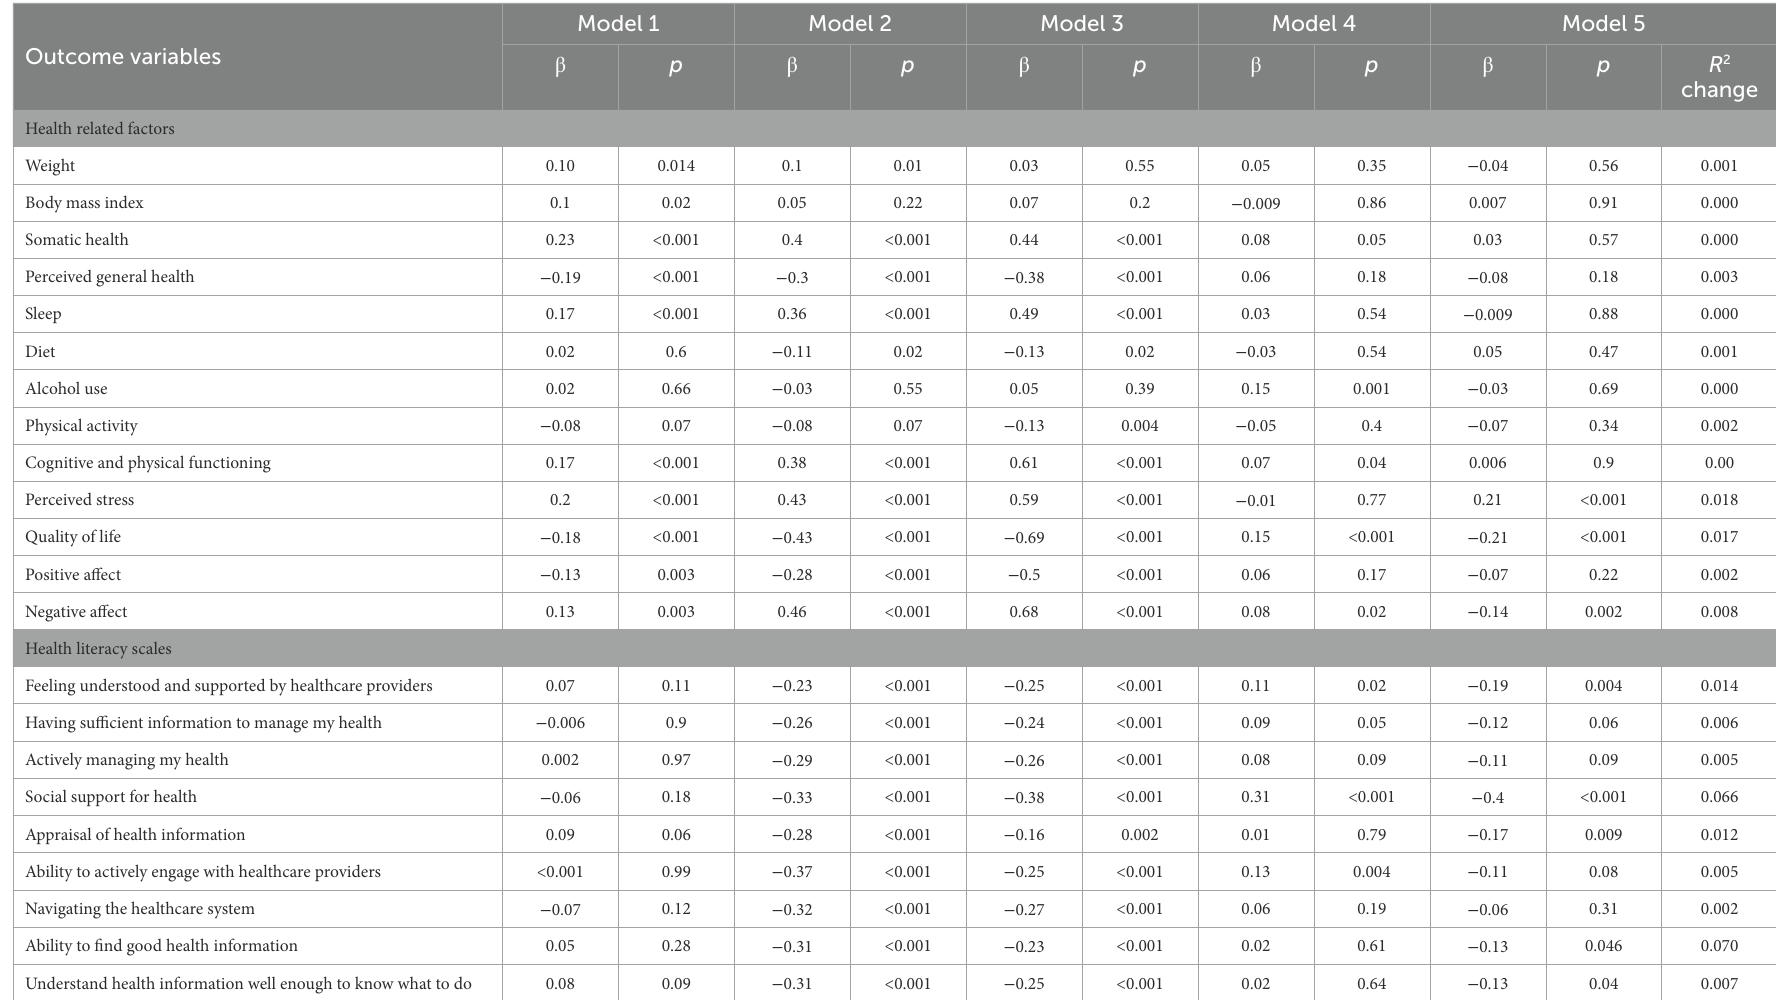
TABLE 4 Hierarchical multiple regression models for unique association between loneliness and health-related factors and health literacy in young